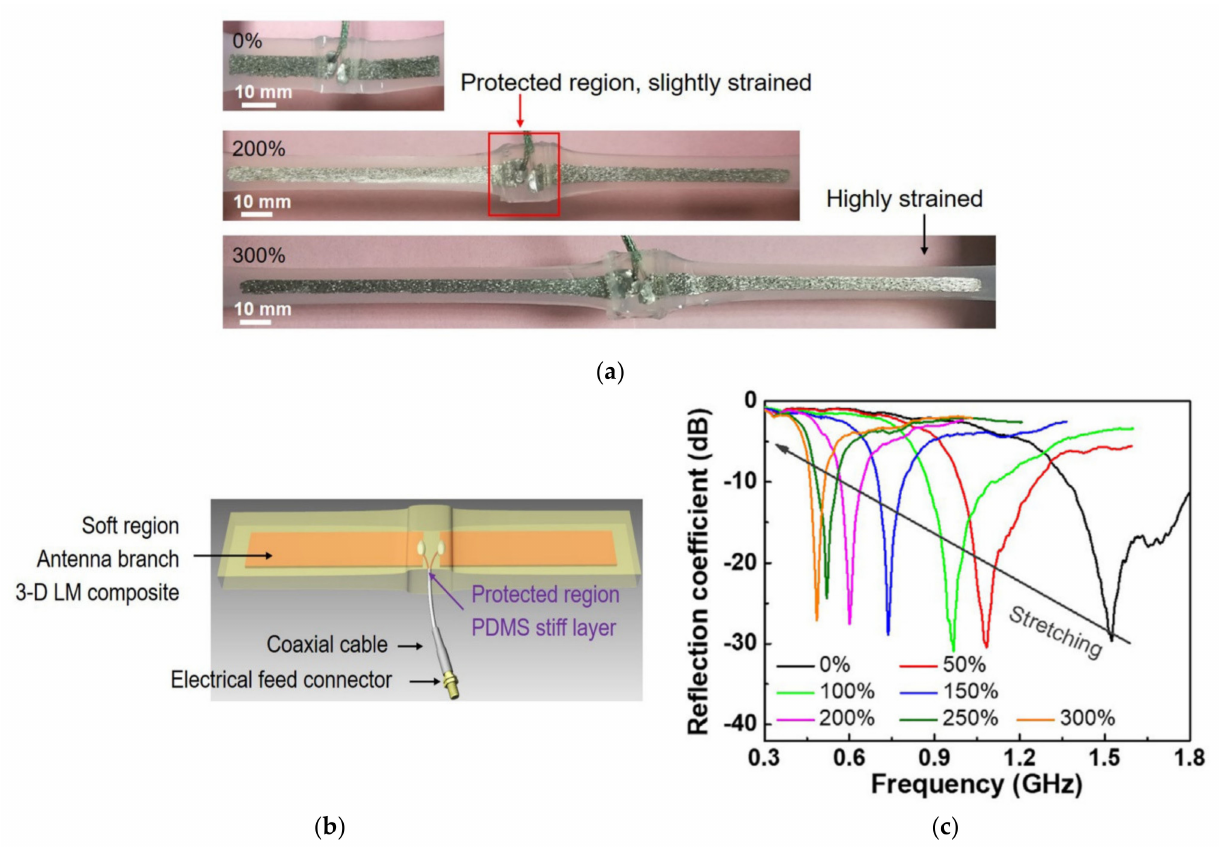
Figure 21. ( a ) Antenna under different strains. ( b ) Schematic diagram of the dipole antenna. ( c ) Frequency response of the reflection coefficient of the antennas under different tensile strains. Reprinted with permission from Ref. [69]. Copyright 2020